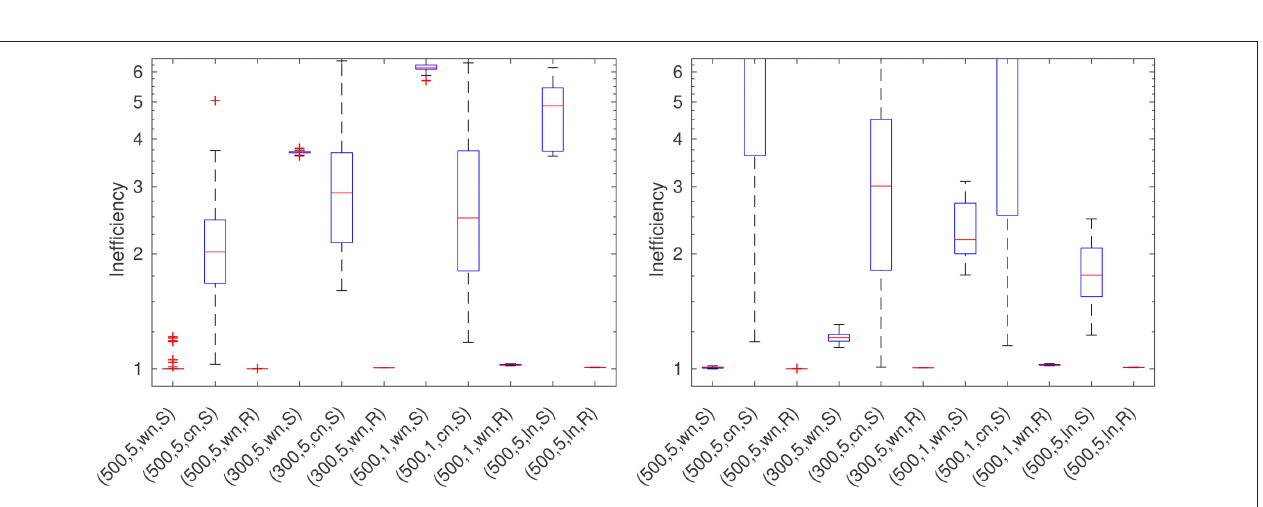
FIGURE 9 | MGCV for the RFMP (Left) and the ROFMP (Right)